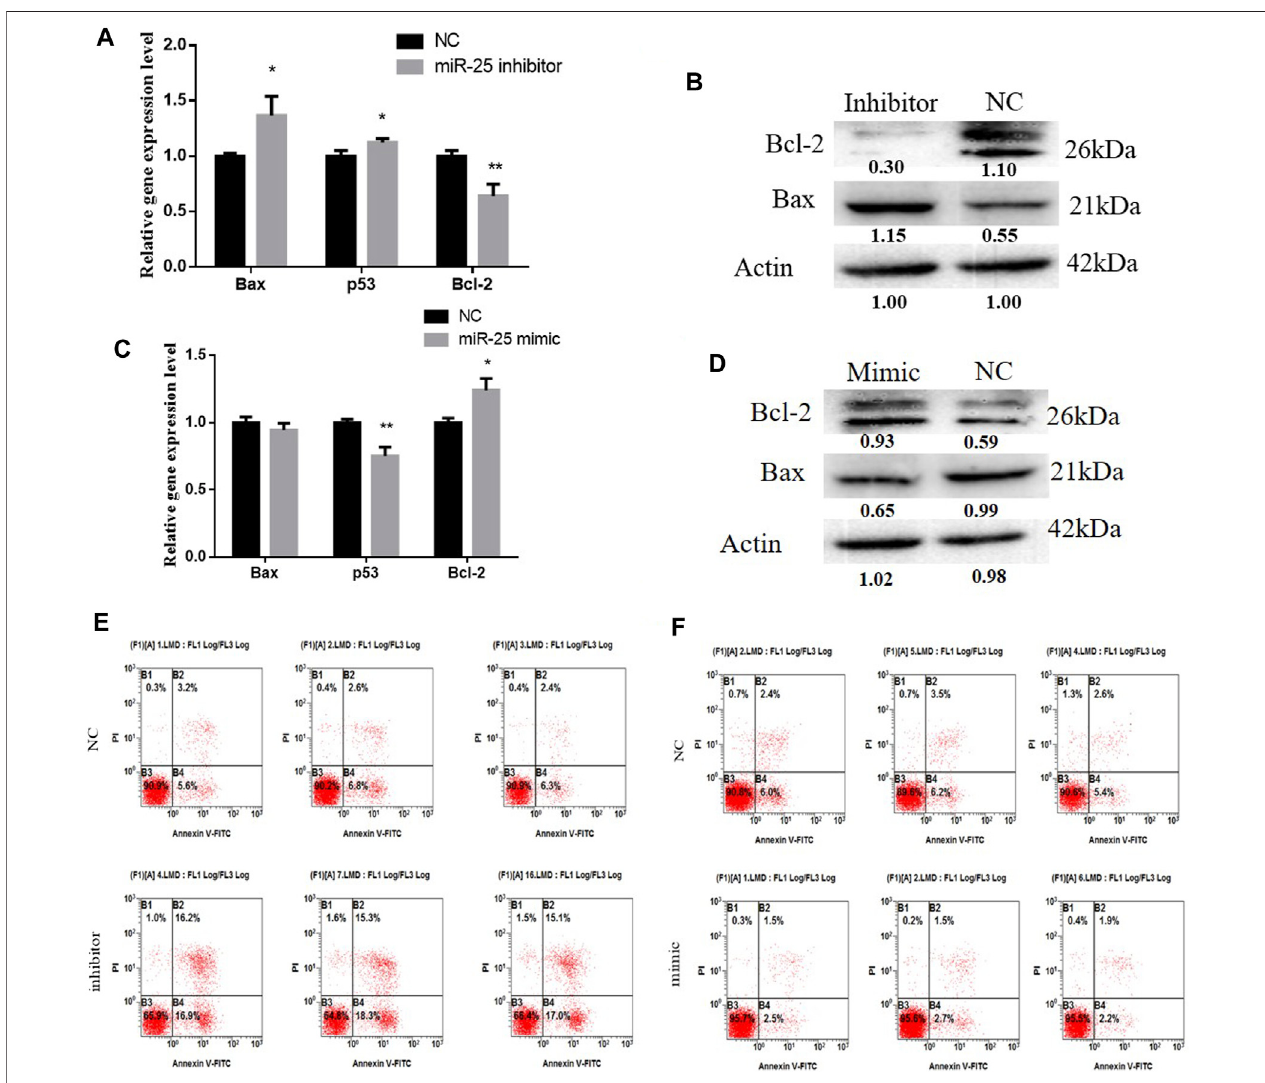
FIGURE 4 | The function of miR-25 for BGC823 cell apoptosis. (A) After loss of miR-25, genes (Bax, p53, Bcl-2) associated with apoptosis were detected by RT- qPCR. (B) After loss of miR-25, Bax and Bcl-2 protein level were detected by western blot. (C) After gain of miR-25, genes (Bax, p53, Bcl-2) associated with apoptosis weredetectedbyRT-qPCR. (D) AftergainofmiR-25,BaxandBcl-2proteinlevelweredetectedbywesternblot. (E) AfterlossofmiR-25,cellapoptosiswasdetectedby Annexin V-FITC reagent. (F) After gain of miR-25, cell apoptosis was detected by Annexin V-FITC reagent. Value in graphs represents means ± SD. At least three independent experiments were carried out. ** p < 0.01; * p <